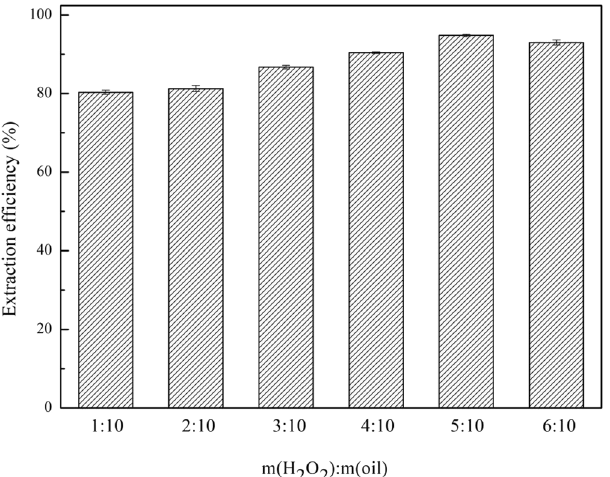
Figure 4. The effect of oxidant amount on the extraction efficiency (experimental conditions: 1.2 g (TBAC/2p- TsOH)/rGO, 0.5 g simulated oil (1600 mg/L sulphur content), 25 °C, 800 rpm, 60 min).